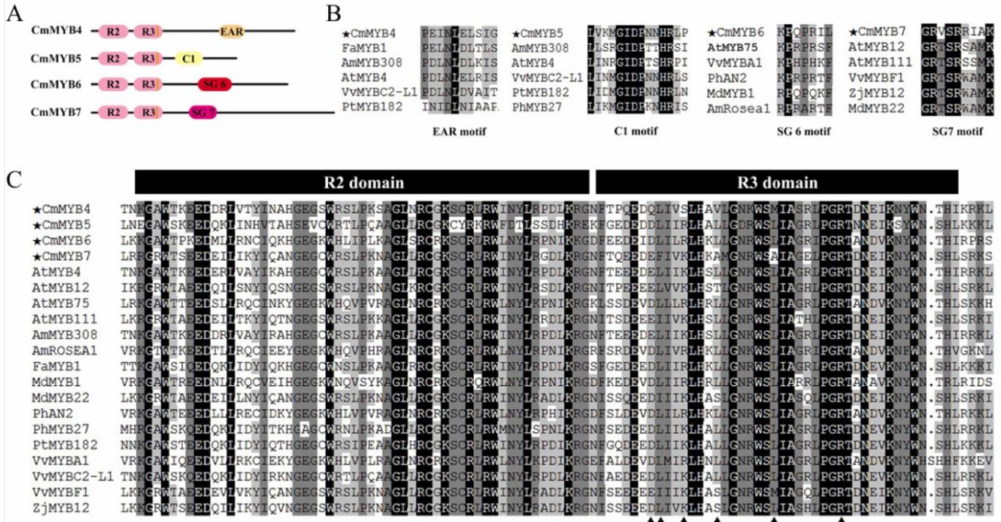
Figure 2. Diagram and alignment of R2R3-MYBs related to flavonoid biosynthesis regulation in other plants compared to the four MYBs from the chrysanthemum. ( A ) Structural diagram of the four CmMYB transcription factors. R2 and R3 domains are marked by pink; orange bars in the R3 domain represent bHLH-binding sites; dark yellow, light yellow, red, and purple indicate EAR, C1, SG6, and SG7 motifs, respectively. ( B ) Amino acid sequence alignment of EAR, C1, SG6, and SG7 motifs contained in the four CmMYB transcription factors and in other plants. ( C ) Amino acid sequence alignment of the R2 and R3 domains contained in the four CmMYB transcription factors and in other plants. The GenBank accession numbers of each species are shown in Supplementary Table S1. EAR, element-binding factor-associated amphiphilic repression; SG,